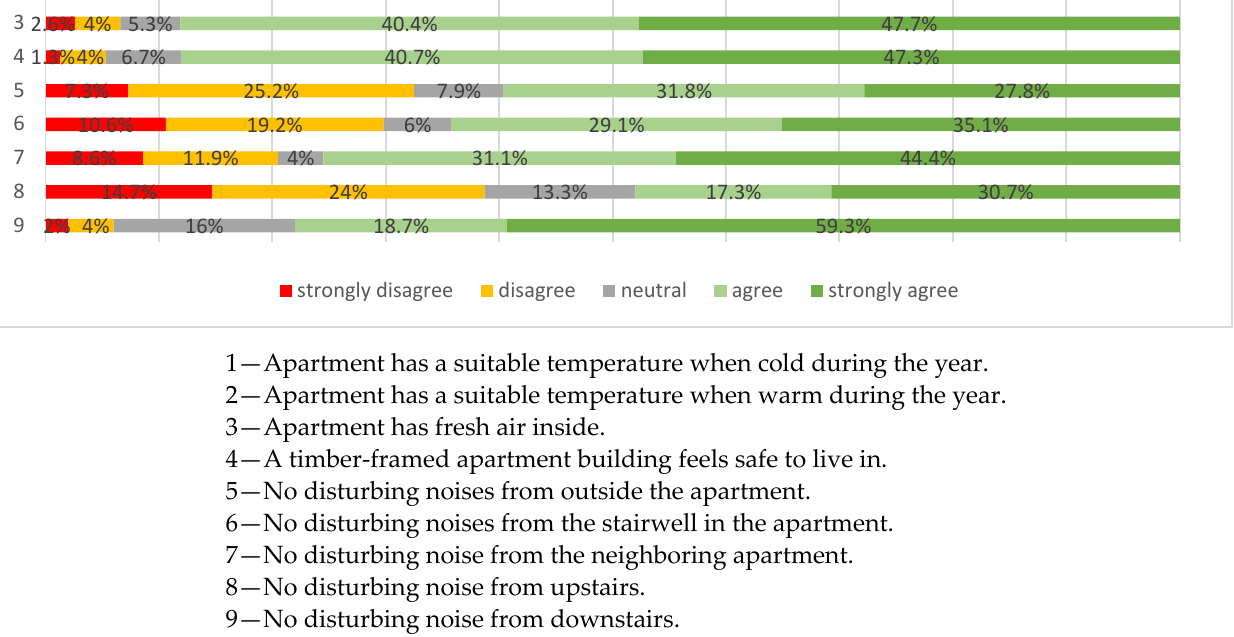
Figure 15. The basic features of the apartment.